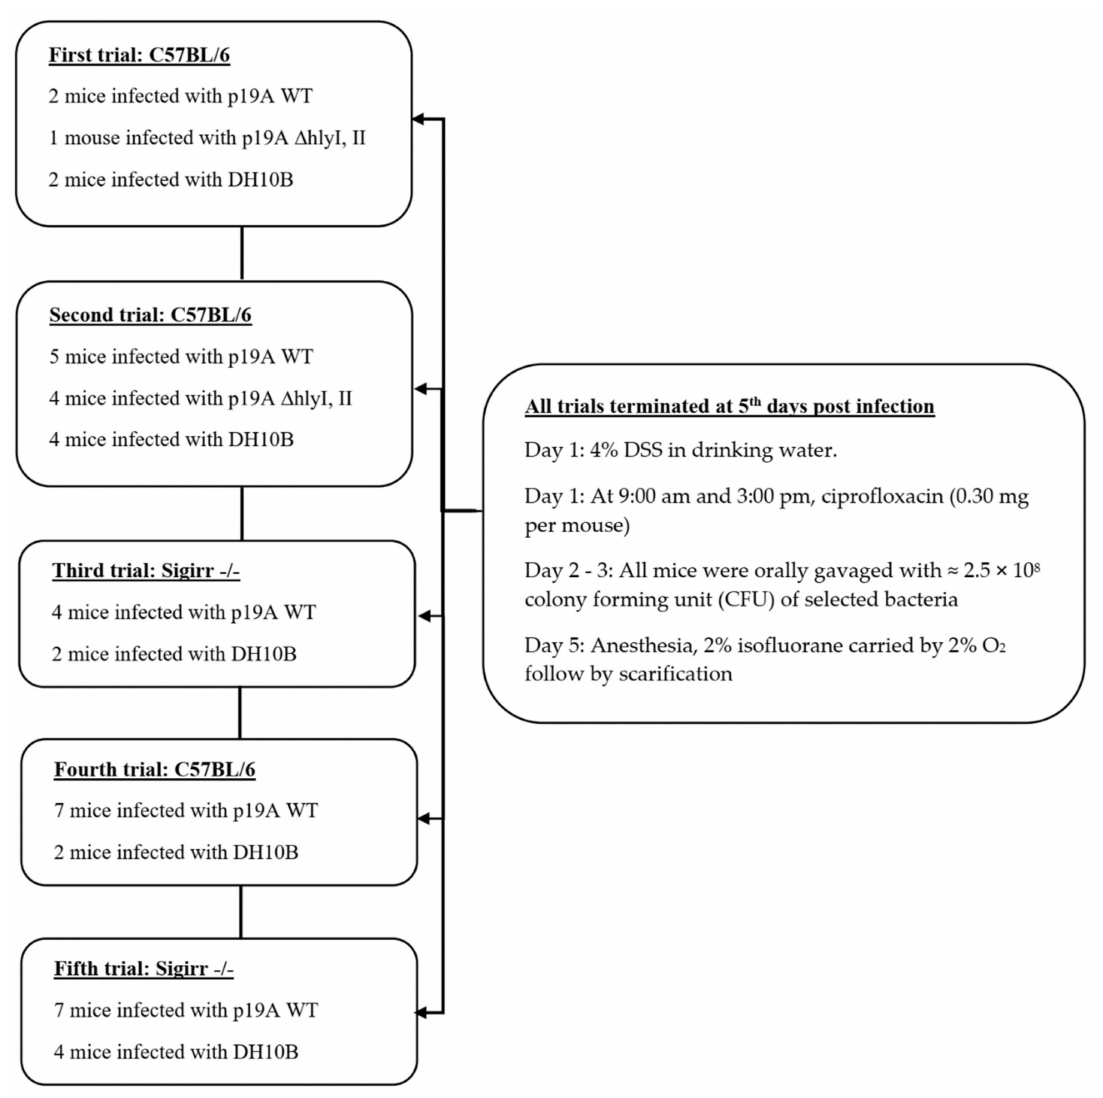
Figure 1. The picture shows a flow diagram of the infection course in Sigirr − / − and C57BL6 mice. The first trial with C57BL / 6 mice was performed to optimize the dosage of antibiotic, dextran sulfate sodium (DSS), and amount of bacteria used to colonize the mice in the experimental group. The second and fourth trials were the same experiment performed twice, to control the outcome in the C57BL / 6 mice model. Trials 3 and 5 were the same experiment performed twice, to control the outcome in the Sigirr − / − mice